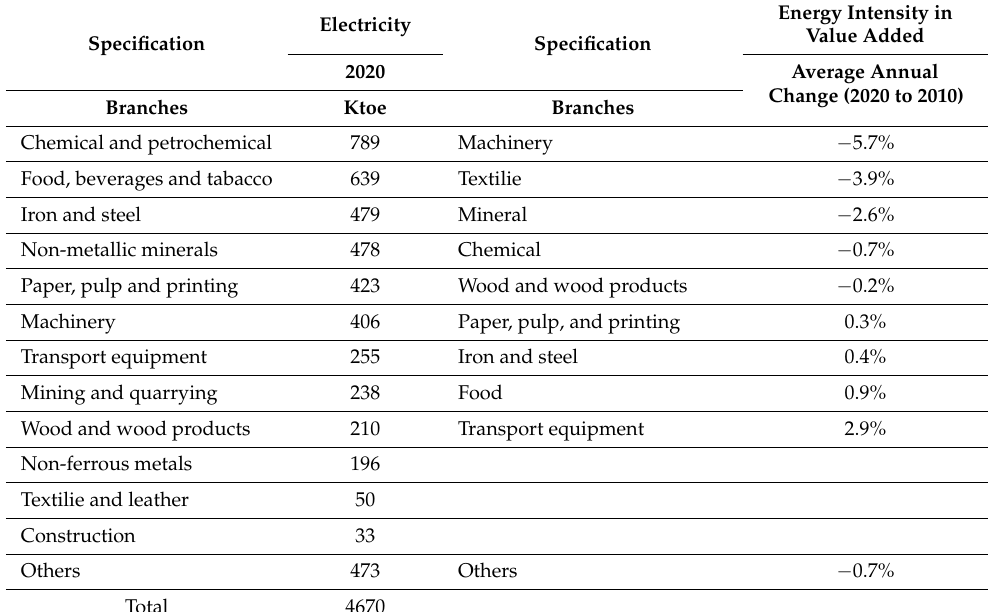
Table 2. Electricity and energy intensity in Polish industry by branches.